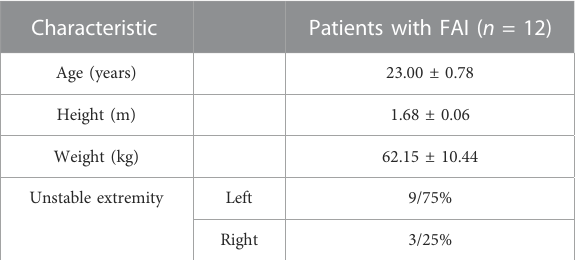
TABLE 1 Sociodemographic characteristics at